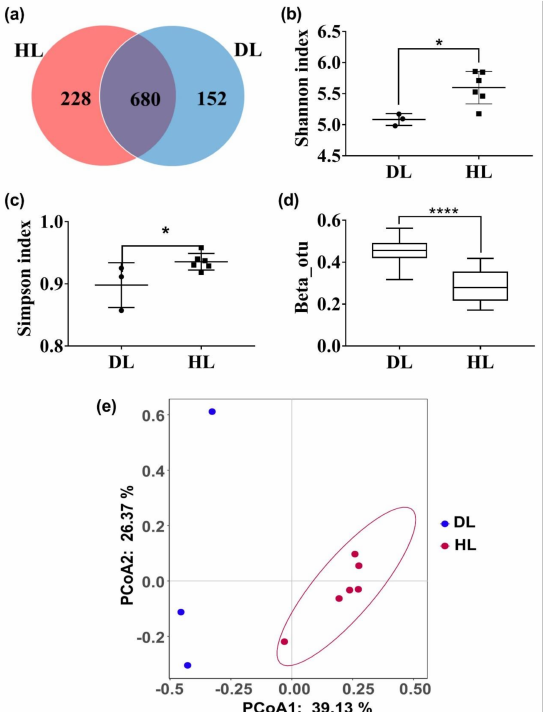
Figure 3. Fecal microbiota characteristics in three kids with diarrhea (DL) and six healthy kids (HL) collected at day 0. Bacterial 16S rRNA genes were amplified and sequenced. ( a ) OTU Venn Diagram, ( b ) Alpha diversity (Shannon index), ( c ) Alpha diversity (Simpson index), ( d ) Beta diversity, and ( e ) PCoA analysis (PCoA1 = 39.13%, PCoA2 = 26.37%) of the HL and the DL groups. Data are mean ± SEM. * p < 0.05, **** p <